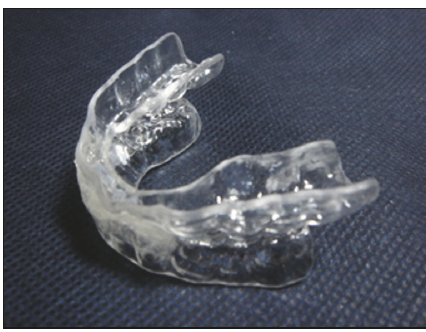
Figure 1: An oral